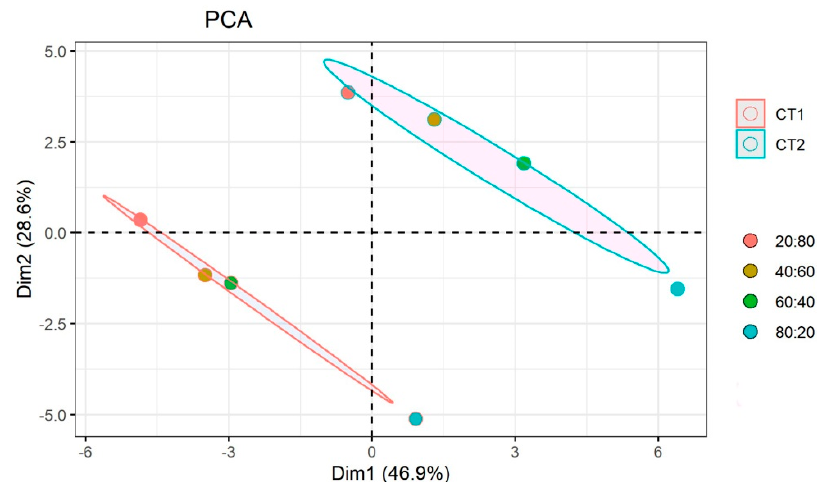
Figure 1. Principal Component Analysis of the basil response. Each condition is represented by a circle, colored according to the different NO 3 − :Cl − ratios (20:80, 40:60, 60:40, 80:20). For each cut (CT1 and CT2), the plot displays in different colors the confidence ellipse around the mean point (not shown). The confidence level was 0.95. Color legend is reported on the right-hand side.